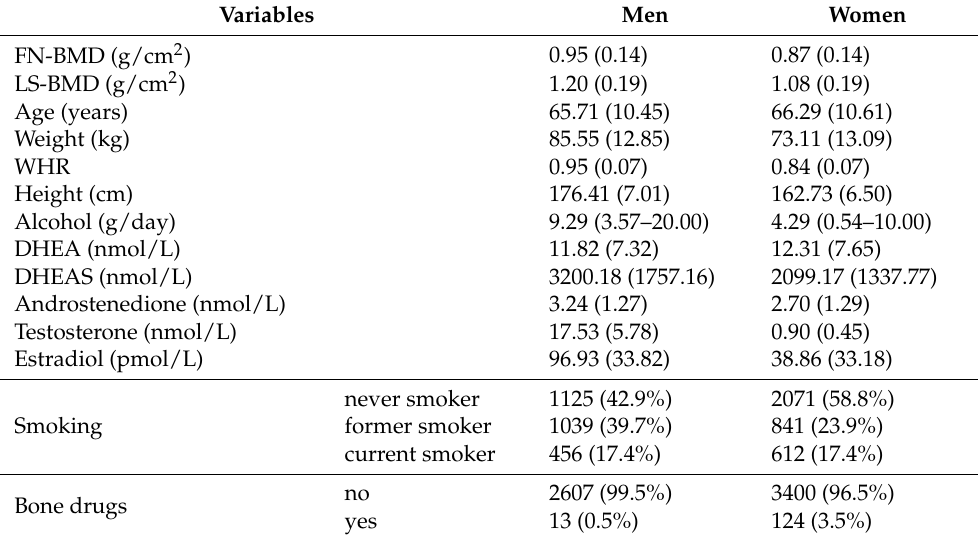
Table 2. Demographic characteristics of the Rotterdam study cohorts. Values are mean